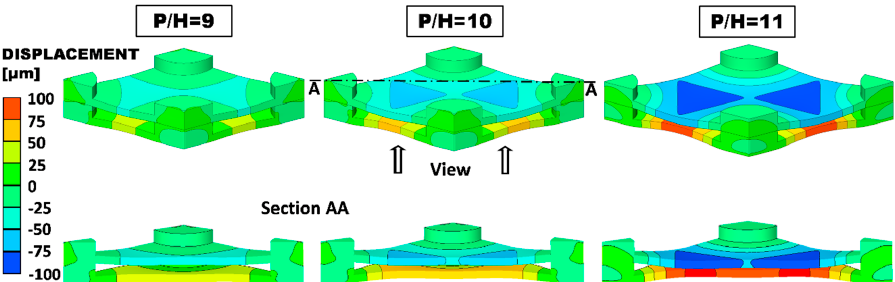
Figure 4. Deformations for different P / H ratios under TMP = +0.8 bar. The quantity shown is the displacement in the direction orthogonal to the undeformed membranes. Top: external view; bottom: view after sectioning by a diagonal plane AA.